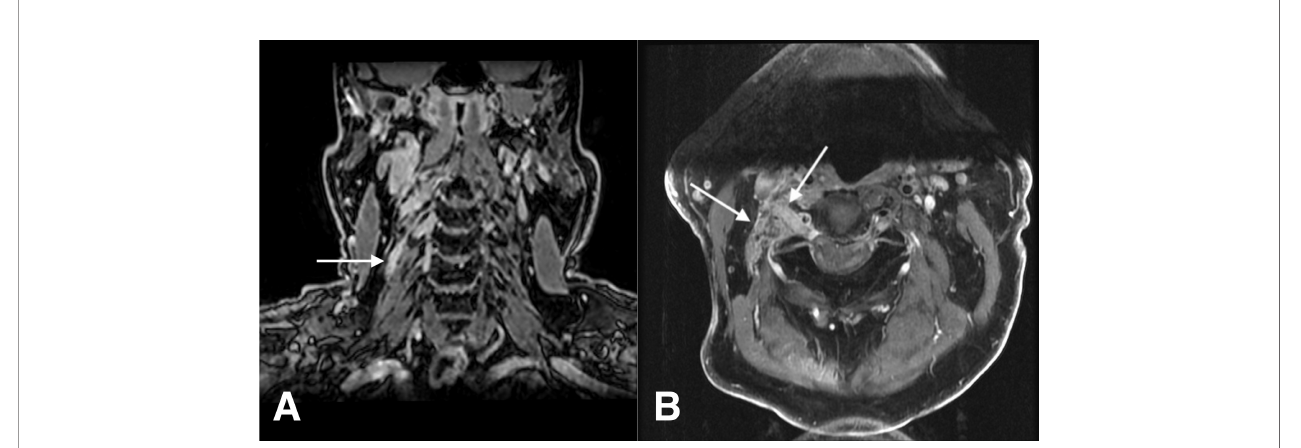
FIGURE 1 | Case 1: a 74-year-old man with squamous cell carcinoma. (A) Coronal fat-suppressed contrast-enhanced T1-weighted image shows a thickening, abnormally enhancing right C4 nerve (arrow). (B) Axial fat-suppressed contrast-enhanced T1-weighted image shows thickening and abnormal enhancement of the right C3 nerve, from the dorsal root ganglion through its course through the posterior cervical space